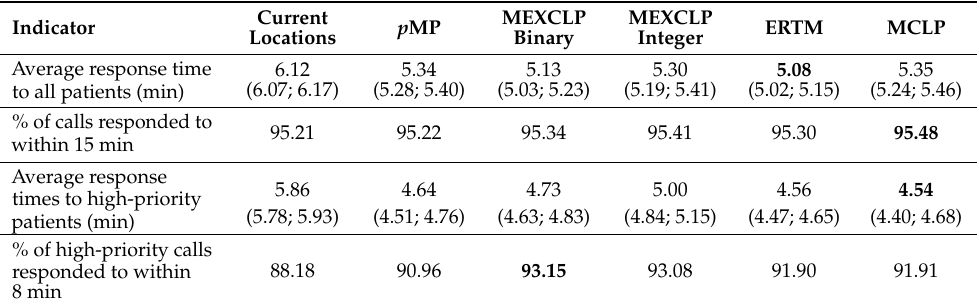
Table 2. Performance indicators for different distributions of the EMS stations in the city of Prešov, LandScan model of